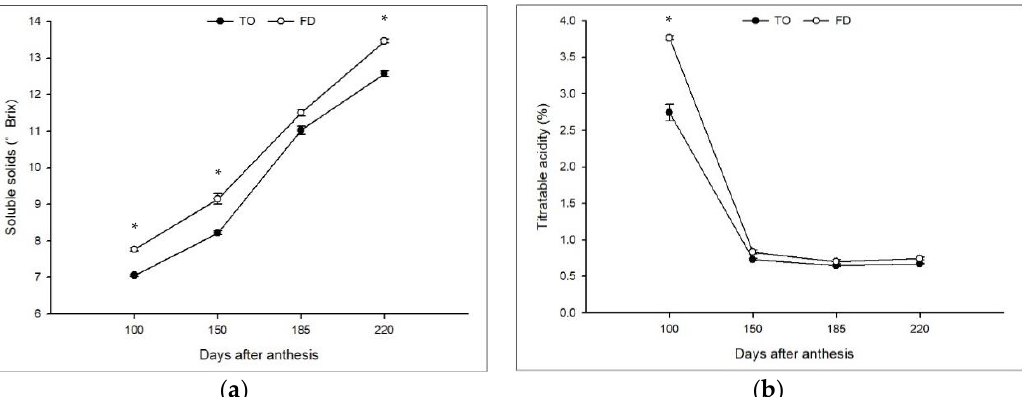
Figure 2. Change of soluble solids ( a ) and titratable acidity ( b ) in ‘Minihyang’ fruits grafted on trifoliate orange (TO) and Frying Dragon (FD) rootstocks. * Mean separation within columns by T-test at 5% level.